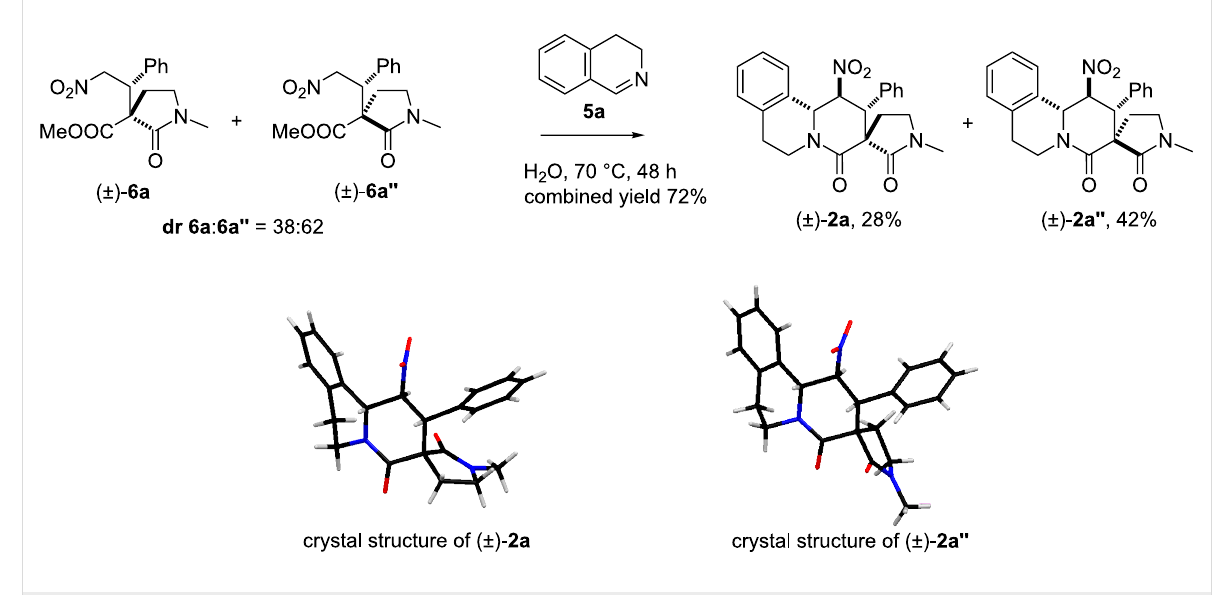
Scheme 4: Nitro-Mannich/lactamisation cascade of diastereomeric Michael adducts 6a , 6a’’ with cyclic imine 5a .